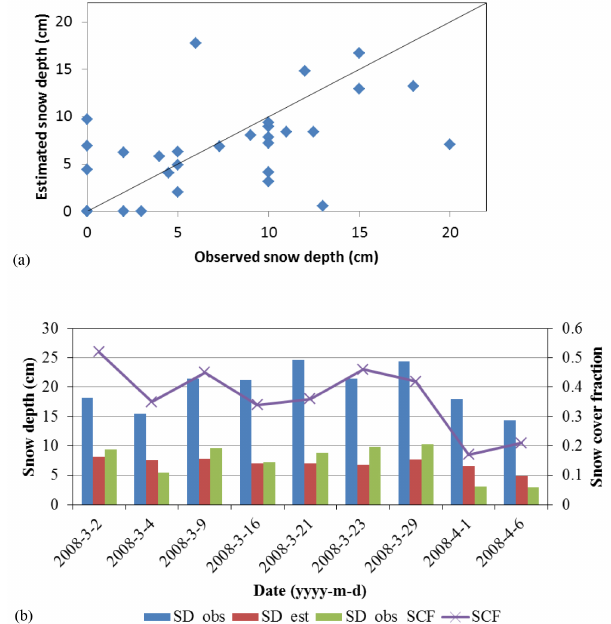
Figure 6. Comparison between measured snow depth and estimated snow depth from AMSR-E/AMSR2 for (a) March 2014 along the observation route and (b) March 2008 in the Binggou watershed: bar graph of observed snow depth, area-weighted observed snow depth and estimated snow depth from AMSR-E, and line graph of snow cover fractions on different